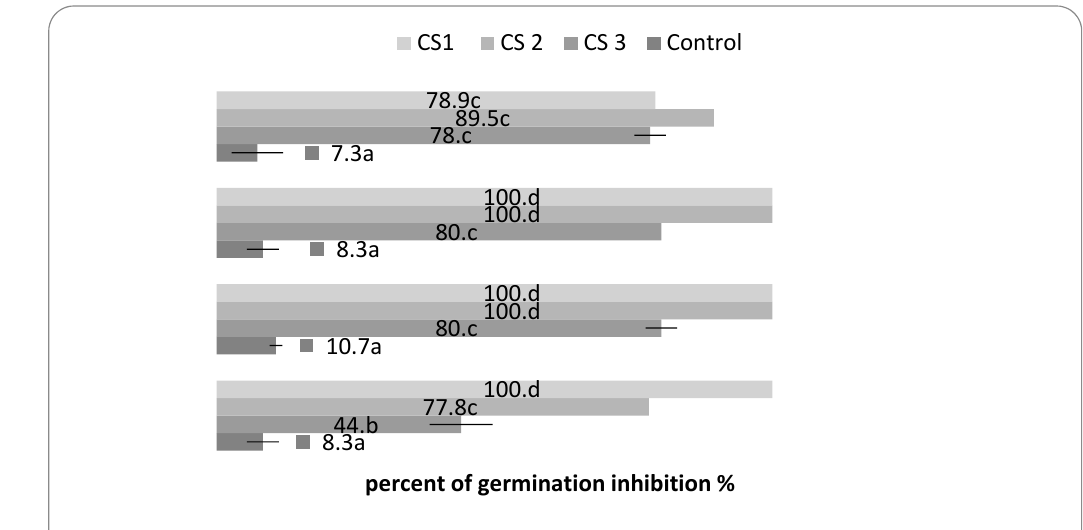
Figure 5. The percent of seed germination inhibition in the presence of CS1 (CEO 10% + SEO 2%), CS2 (CEO 1% + SEO 0.2%), and CS3 (0.5% + SEO 0.1%). Between the mean values followed by different letters, there are statistical differences assured for p < 0.05 by t -Test, n = 3. WHEAT, ( Triticum aestivum , Antille cultivar), EGAL ( Echinochloa crus-galli ), CALB ( Chenopodium album ), ARET ( Amaranthus retroflexus ).